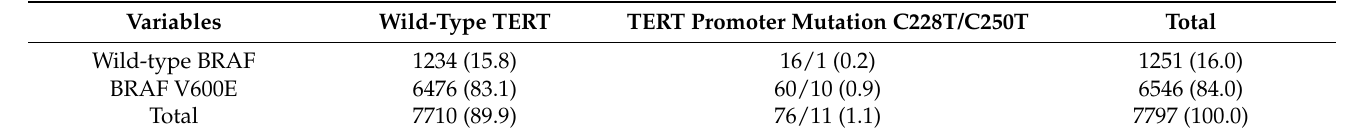
Table 1. Prevalence of TERT promoter and BRAF V600E mutations.